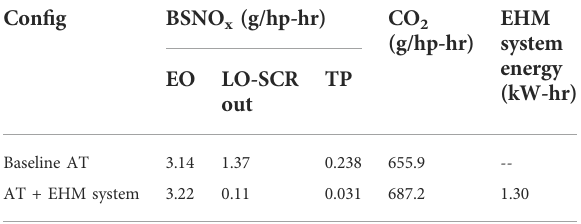
TABLE 8 Stay Hot test